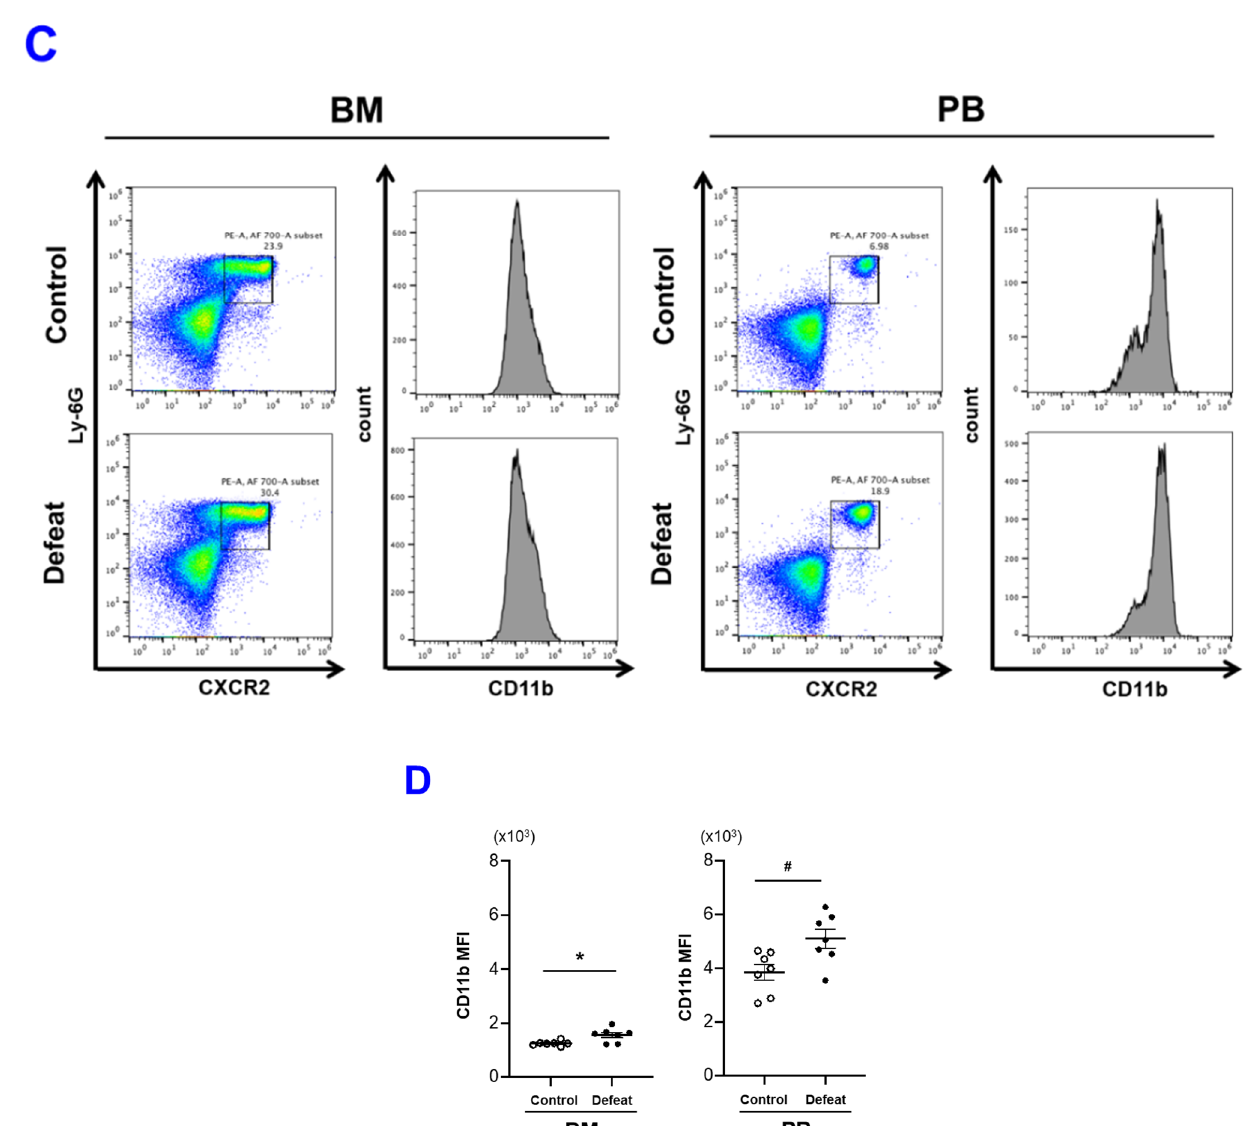
Figure 7. CD11b expression is increased in mature BM neutrophils of defeated mice. ( A , B ) Flow cytometric analysis of PSGL-1 expression in mature BM and PB neutrophils from control and defeated mice. Values represent mean ± standard error of mean (SEM) for six control and six defeated mice; Student’s t -test. BM, bone marrow; PB, peripheral blood. ( C , D ) Flow cytometric analysis of CD11b expression in mature BM and PB neutrophils from control and defeated mice. Values represent mean ± standard error of mean (SEM) for seven control and seven defeated mice. * p < 0.05 vs. mature BM neutrophils from control mice; Welch’s test, # p < 0.05 vs. PB neutrophils from control mice; Student’s t -test. BM, bone marrow; PB, peripheral blood.